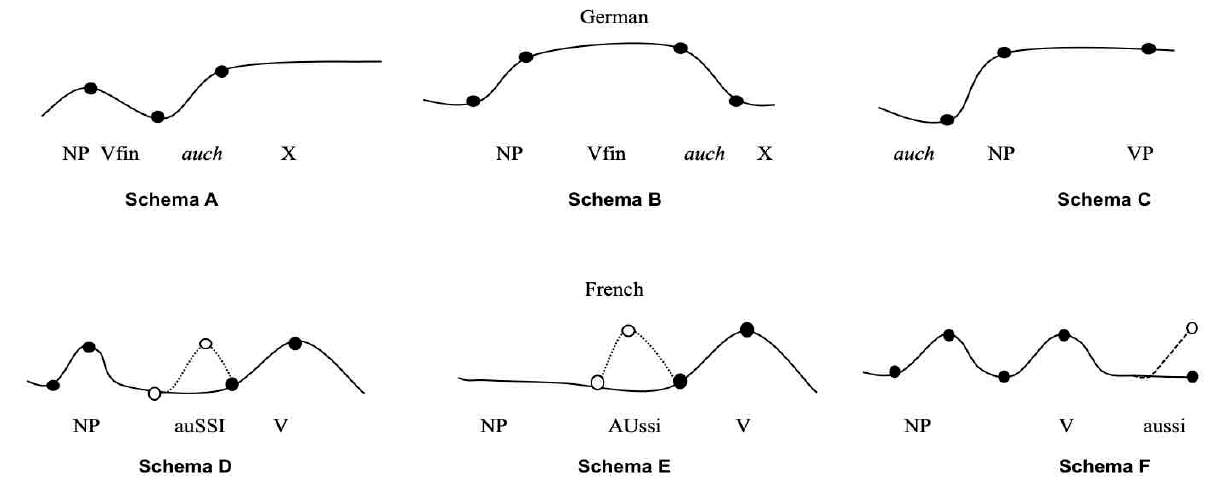
Figure 1. Pitch stylizations of GE. auch and Fr. aussi according to different syntactic positions.